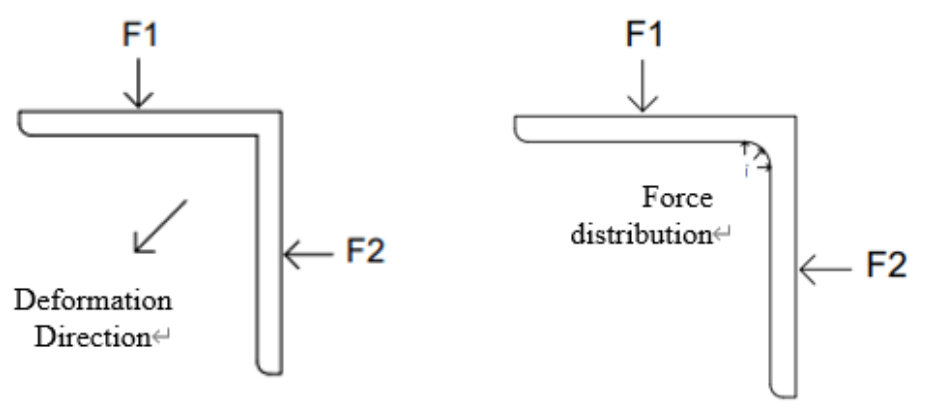
Figure 8. Stress concentration avoidance by rounded structure.